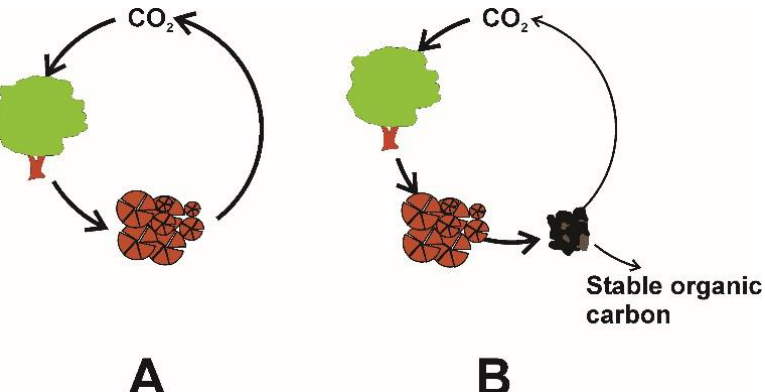
Figure 2. Simplified carbon dioxide cycle. ( A ) CO 2 is photosynthetically converted in carbonaceous plant metabolites. Once the plant dies, the organic material returns back to CO 2 . ( B ) If the organic matter from dead plants is pyrolyzed and then the produced carbonaceous material is applied to soils, the rate of its conversion to CO 2 is reduced, thereby allowing carbon sequestration in soils, reducing the amount of atmospheric carbon dioxide.